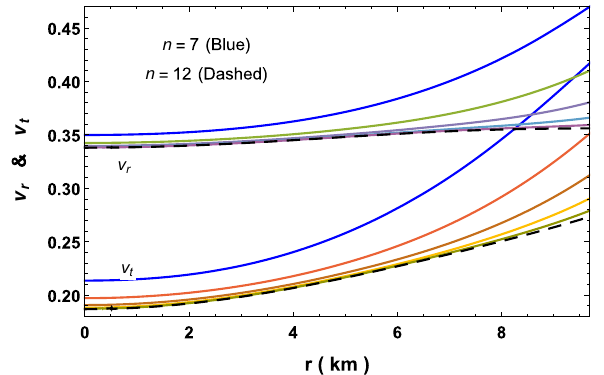
Fig. 10 Velocity of sound profiles of PSR J1614-2230 for M = 1 . 97 M (cid:6) , R = 9 . 69 km and b = 0 . 04